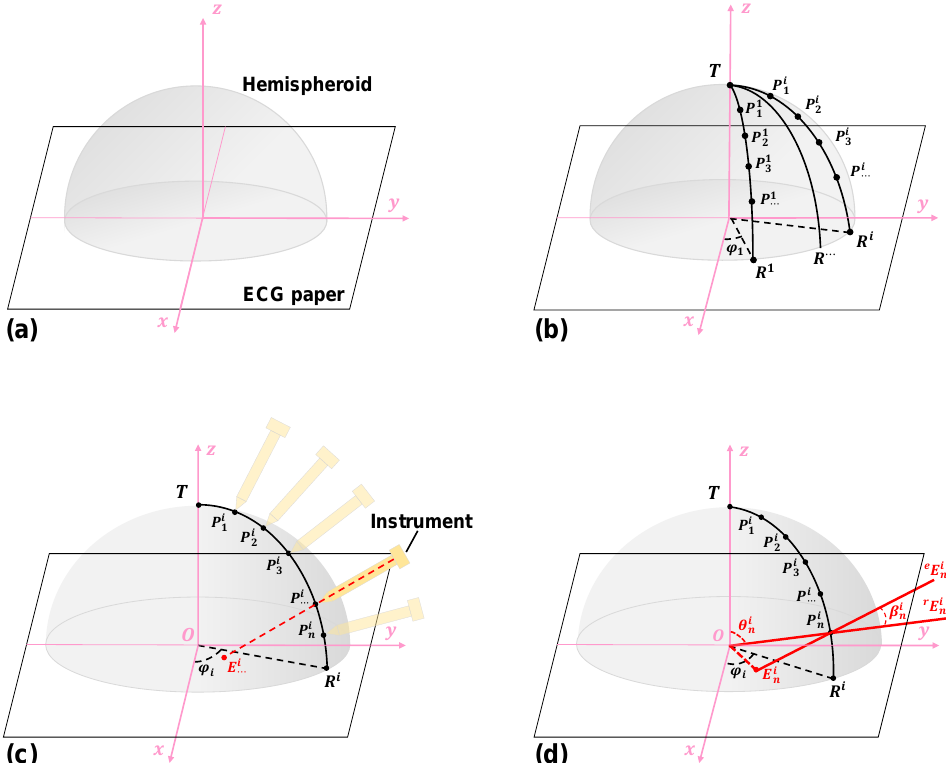
Figure 6. Processing steps of the HTM. ( a ) 3D coordinate definition on the ECG paper. ( b ) Arc marking on the shell. ( c ) Pose measurement on each interest point. ( d ) The computational principle of the pose